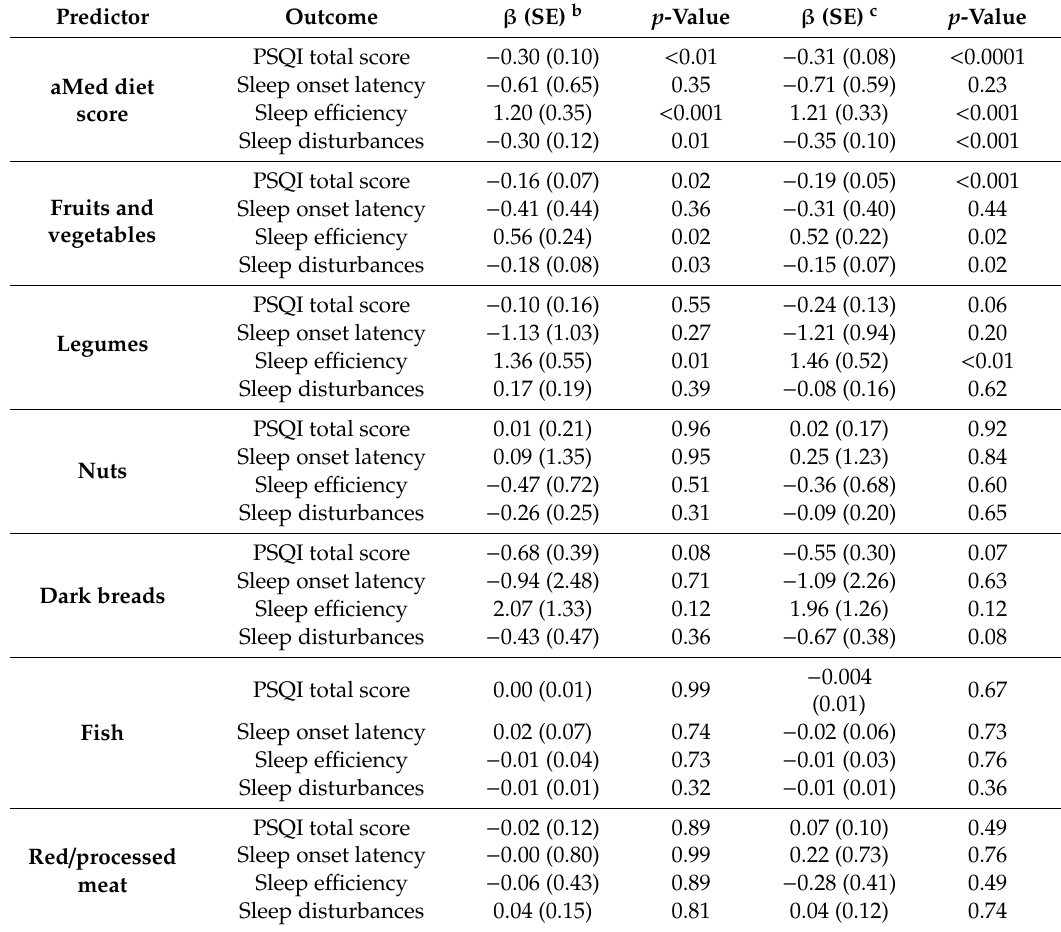
Table 3. Prospective analysis of associations of baseline adherence to an alternate Mediterranean (aMed) diet and intake of food sources included in the aMed score with measures of sleep quality after 1-y a